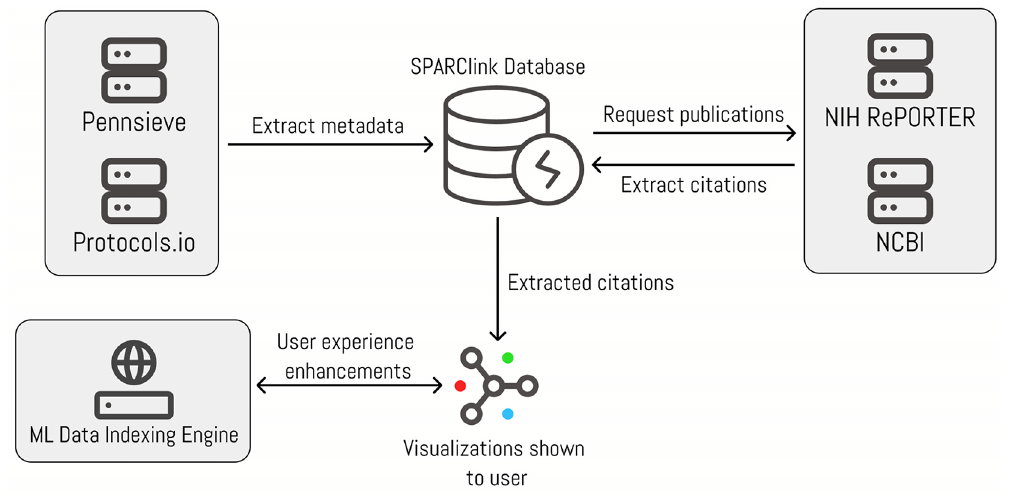
Figure 1. The flow of data between the submodules of SPARClink.